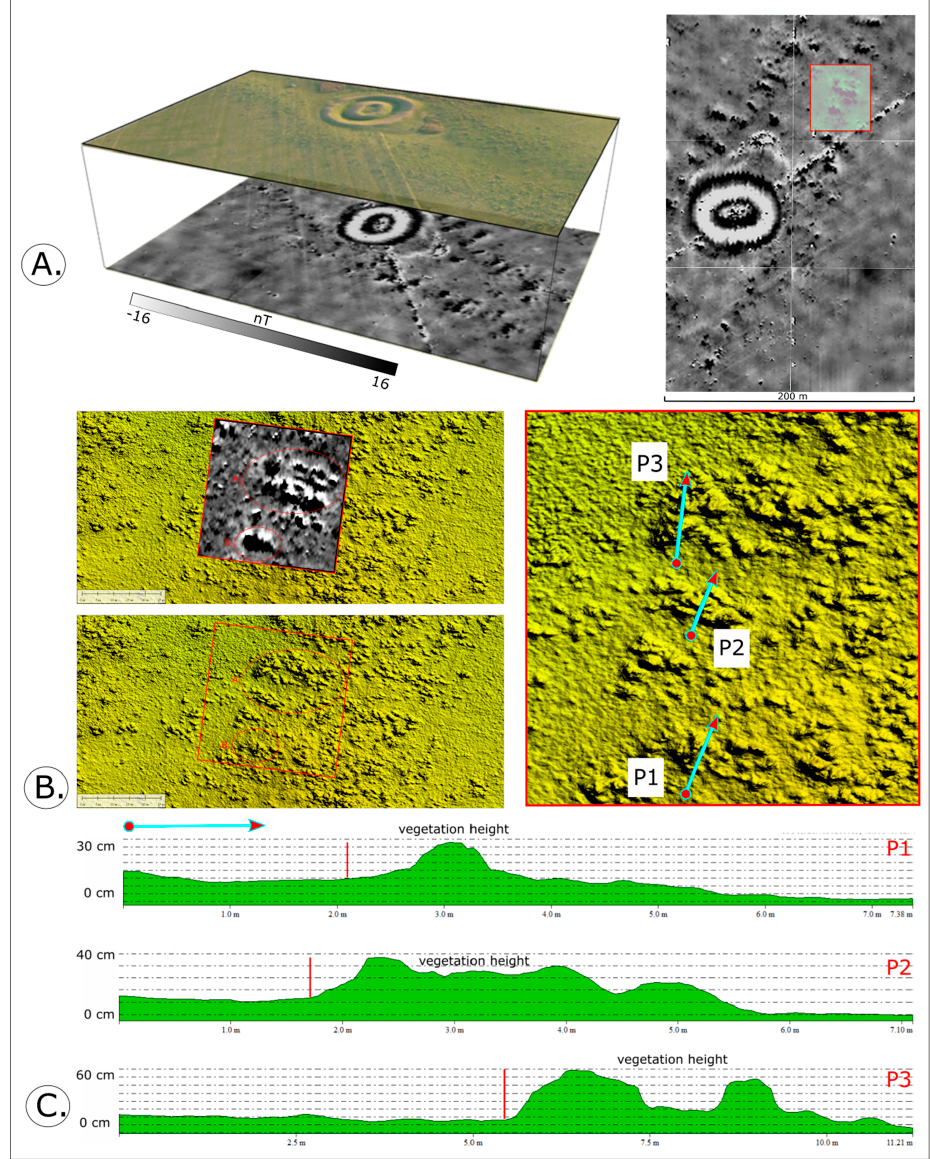
Figure 9. A . Magnetic measurements in comparison with orthophotomosaic; B . Comparison of magnetic measurements with vegetation height—it can be easily observed that the vegetation has a different growth pattern in the areas where magnetic anomalies exist (positive magnetic anomalies, represented with black colours, suggest a disturbance in the topsoil containing more soil nutrients for plants). C . Vegetation profiles show that the growth rates over the magnetic anomalies is higher than their surroundings.